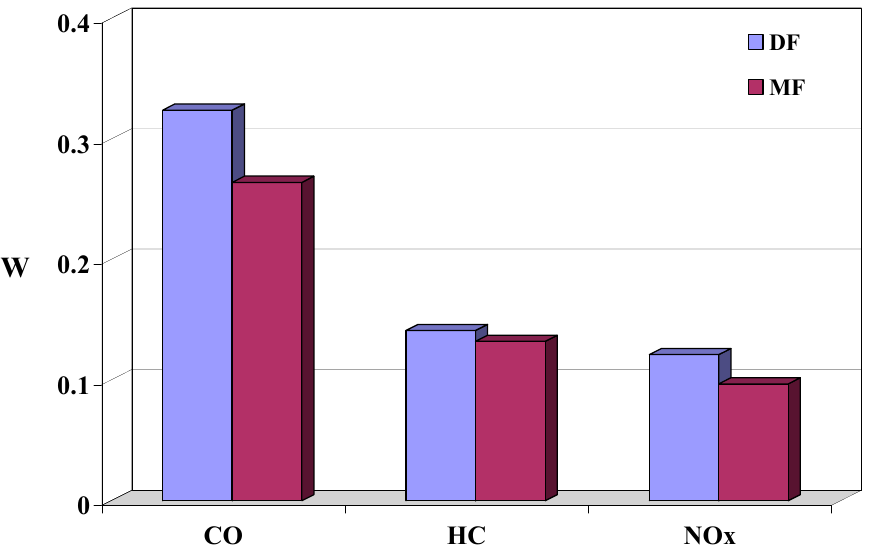
Figure 9. The variation coefficient for the specific brake pollutant emission in all tests for a self- ignition engine running on diesel fuel (DF), and a spark-ignition Cummins 6C8.3 engine running on methane fuel—natural gas (MF).